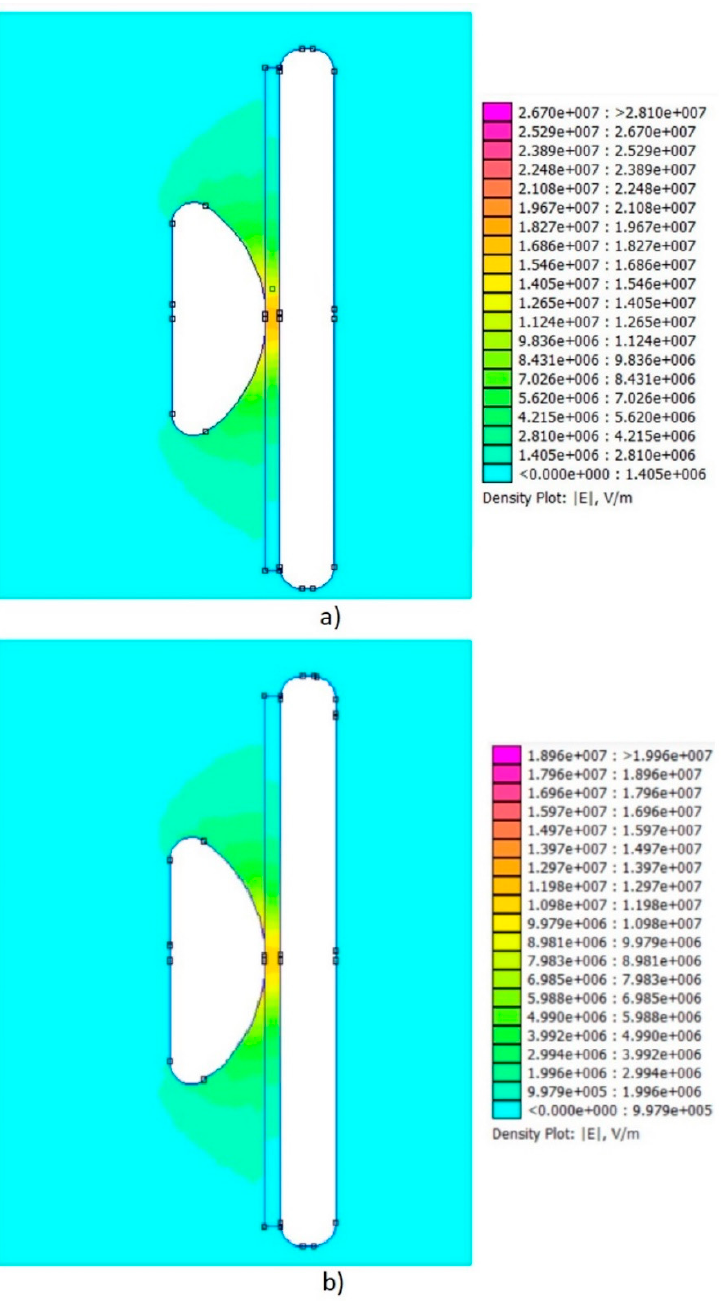
Figure 7. Electric field distribution in the model electrode system for the examples of: ( a ) mineral oil as dielectric liquid, ( b ) synthetic ester as dielectric liquid.